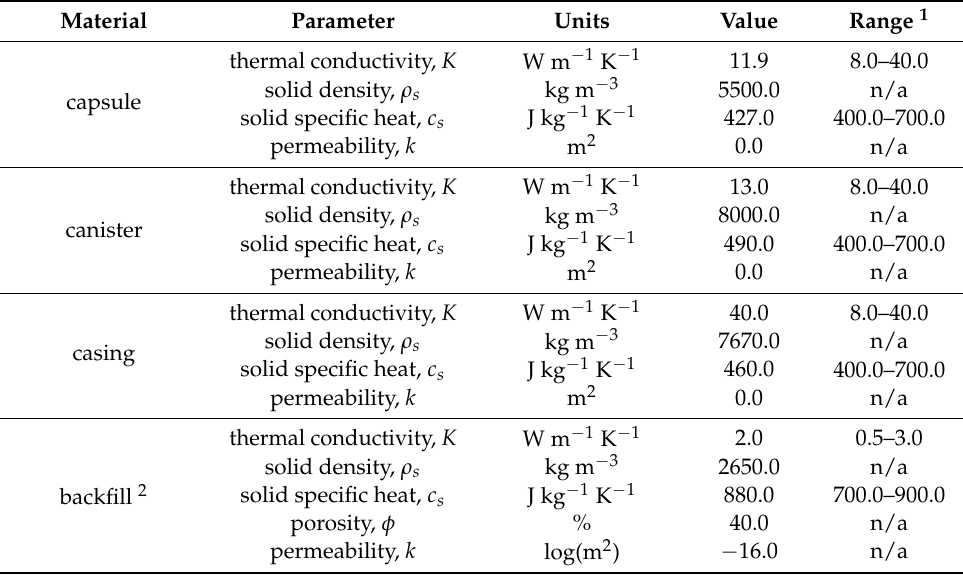
Table 1. Reference parameter